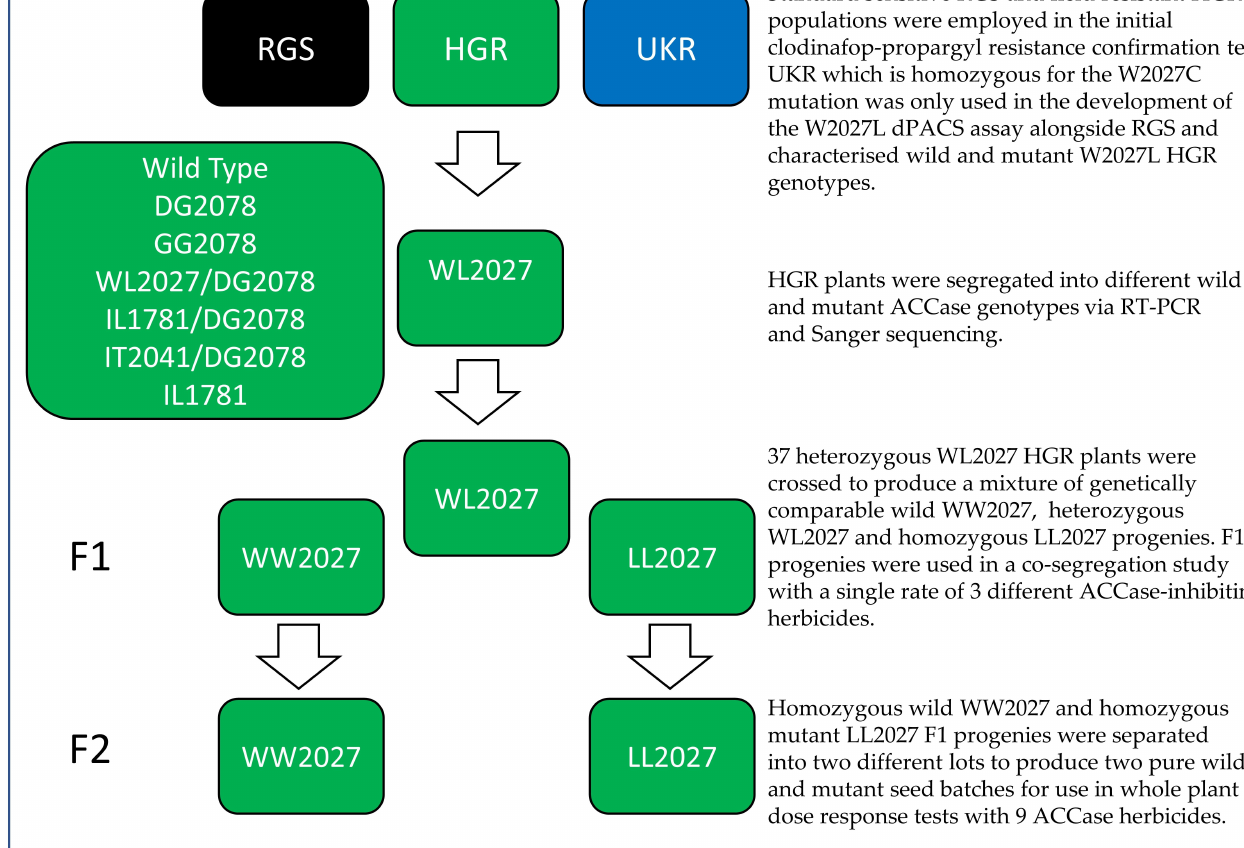
Figure 1. L. multiflorum populations and characterised genotypes used in this